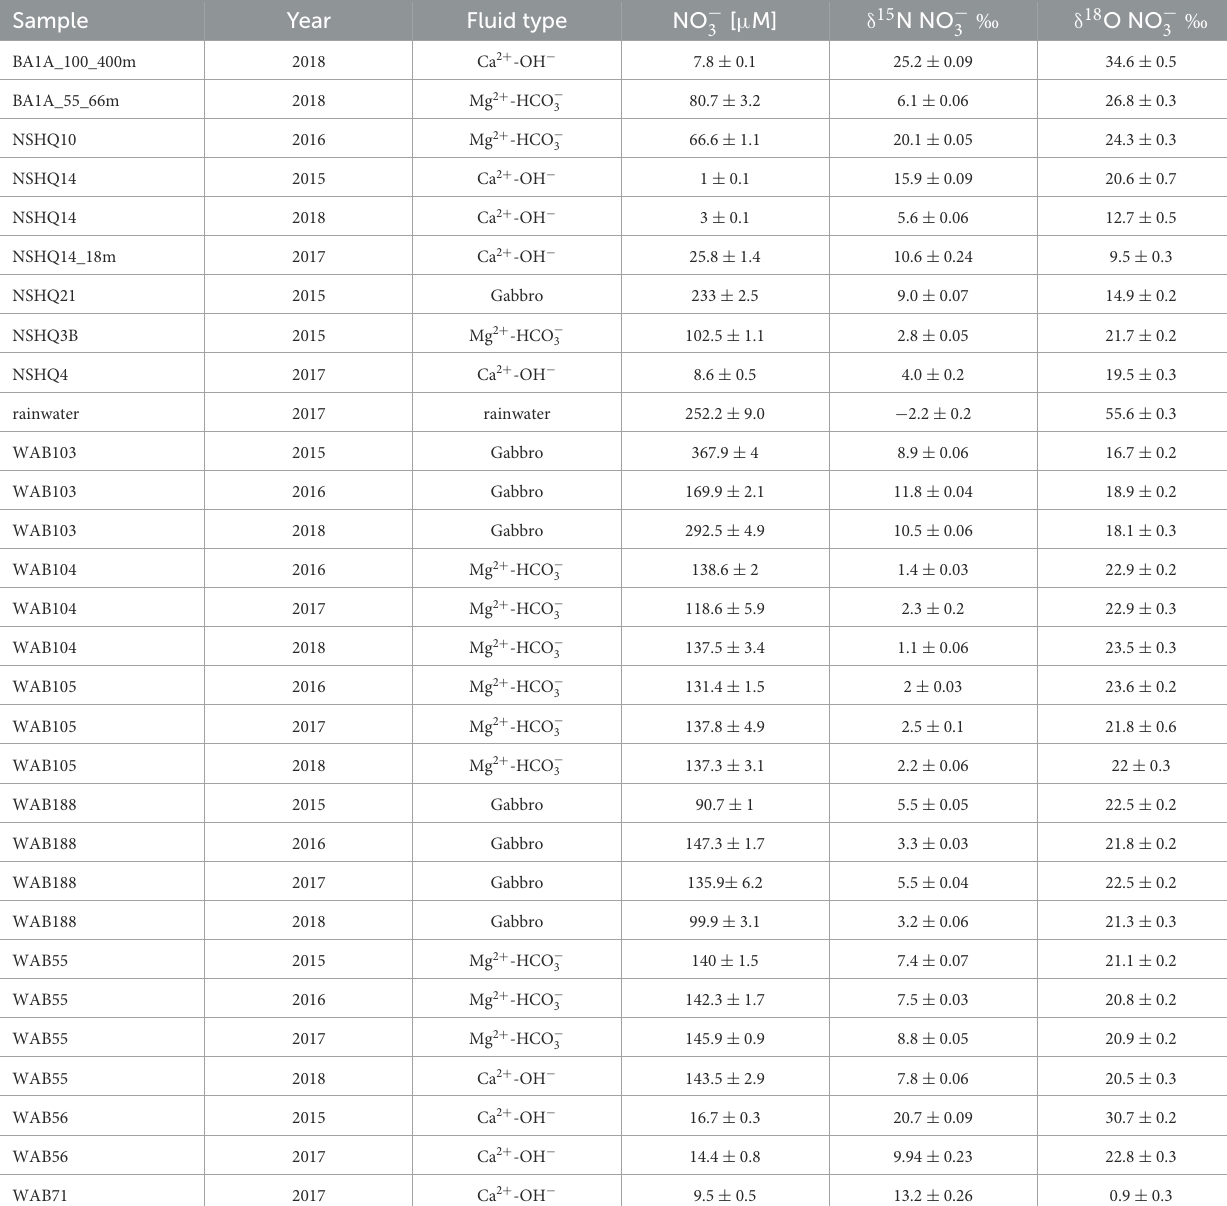
TABLE 2 δ 15 N and δ 18 O of NO − 3 with NO − 3 concentration measured by the denitrifier